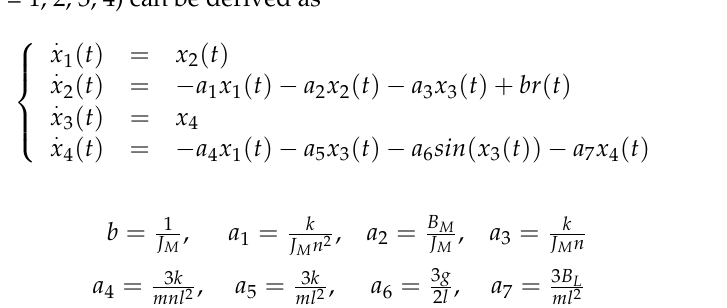
dimensional g -plane (i.e., real axis σ , imaginary axis jω , and time-dependent variable) as illustrated in Figure 4. The stability region in the g -plane is defined from the definition of stability region in the s -plane (see Figure 4).